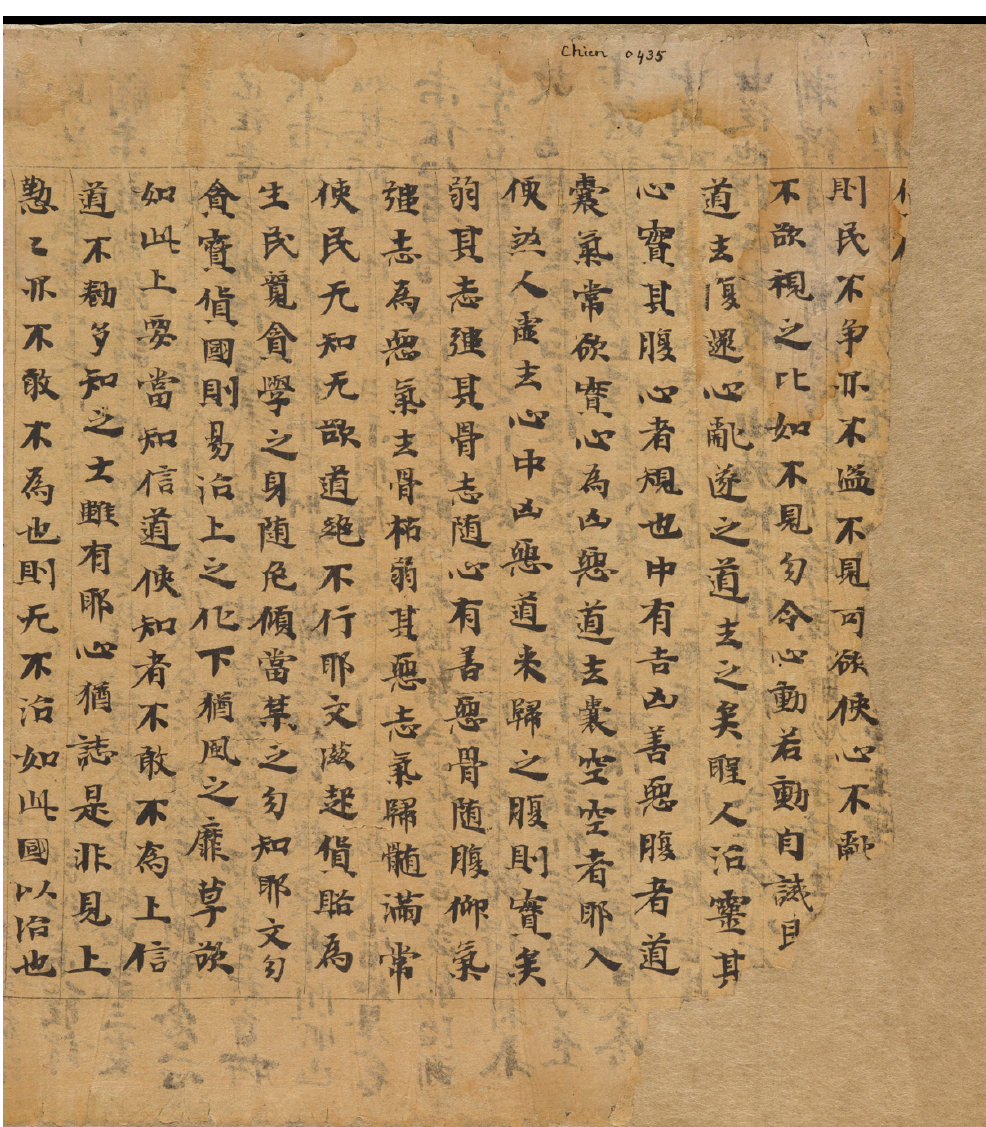
Figure 1. Beginning of the extant Xiang’er Commentary to the Laozi ( Laozi Xiang’er zhu 老子想爾注 ) mainly displaying Laozi 3 and its commentary. Found in the Dunhuang caves and purchased by Sir Marc Aurel Stein (1862–1943). Photo courtesy of the British Library, Or.8210/S.6825, © The British Library Board. The title, main text and commentary are all written in the same style, blurring the boundary between main text and commentary.